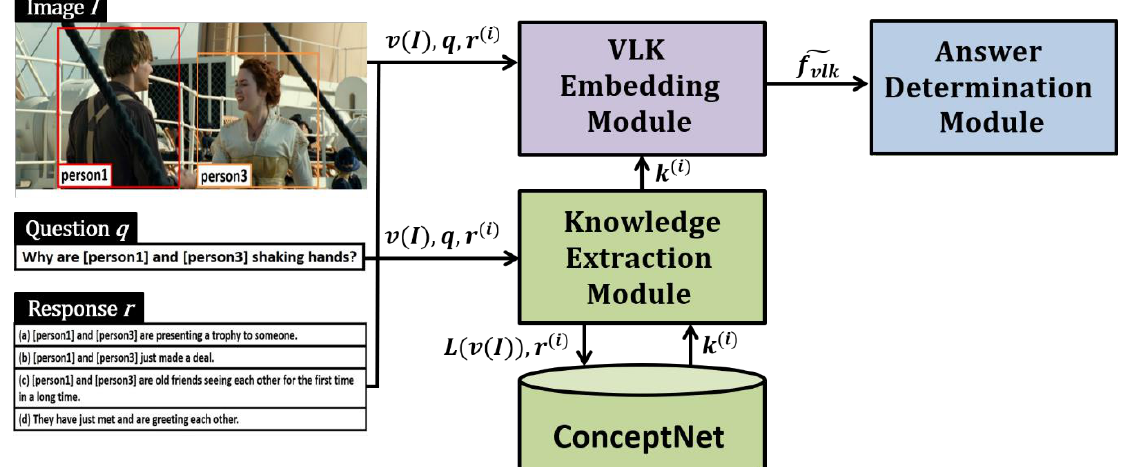
Figure 2. Overall structure of the proposed ViLaKC model.